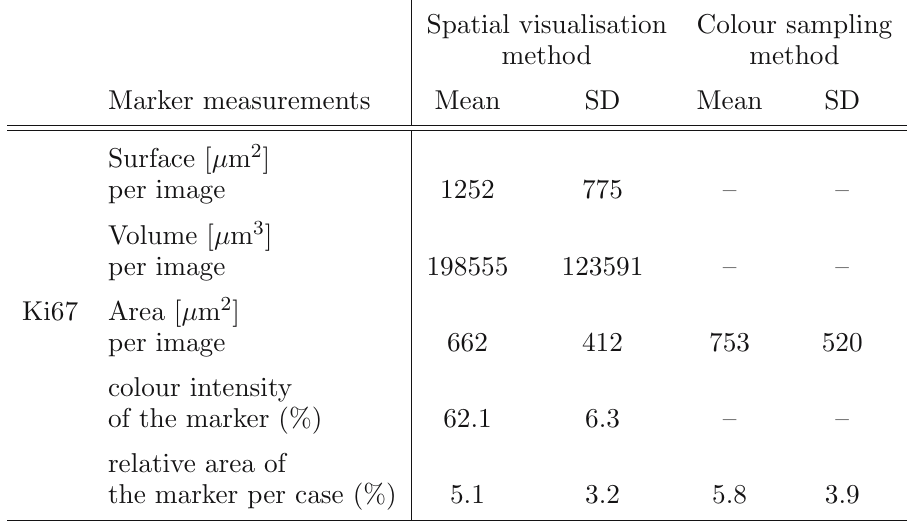
Fig. 3 Segmented cell nuclei with PCNA after orthogonal projection of their spatial representation. Table 2 Quantitative measurements of Ki67 in twenty chronic parathyroiditis